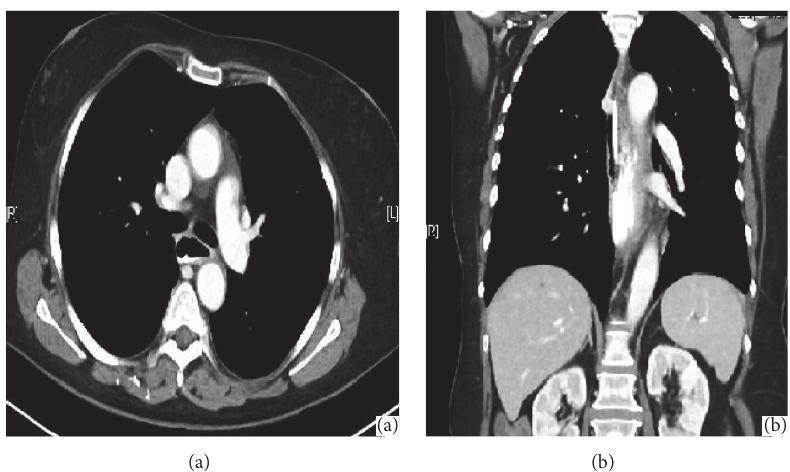
Figure 3: Follow-up CT showing resolving haematoma ((a) sagital and (b) coronal view).